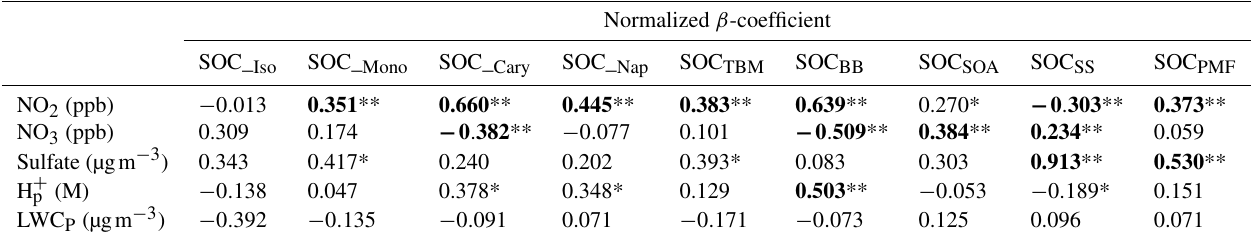
Table 4. Results of multivariate linear analysis of PMF and TBM-resolved SOCs, NO 2 , NO 3 , sulfate, particle acidity (H + p ), and total particle- phase liquate water content (LWC P ). **: P < 0 . 01; *: P < 0 . 05. Note that significant regressions are